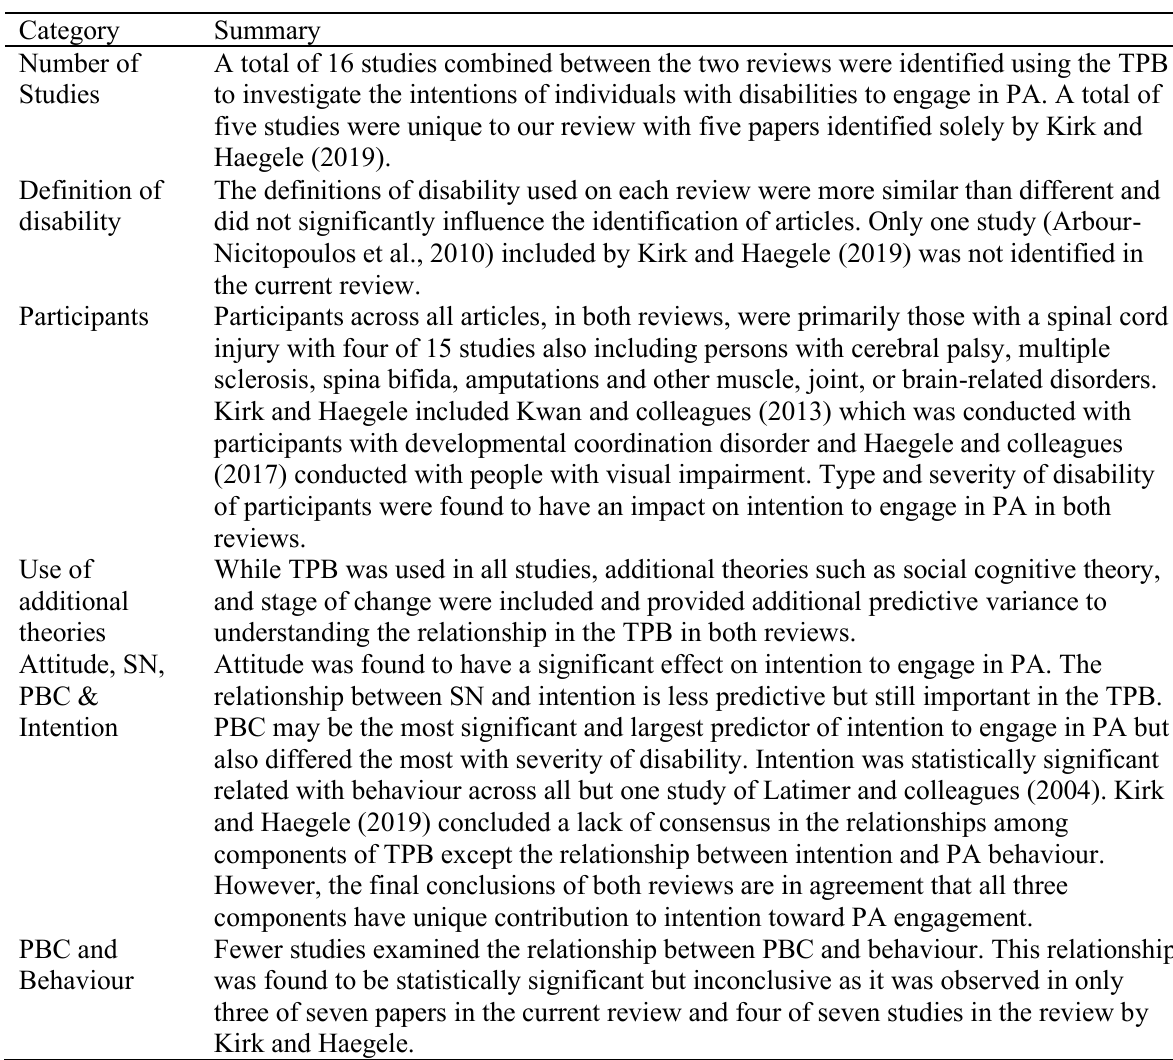
Table 4 . Summary of key